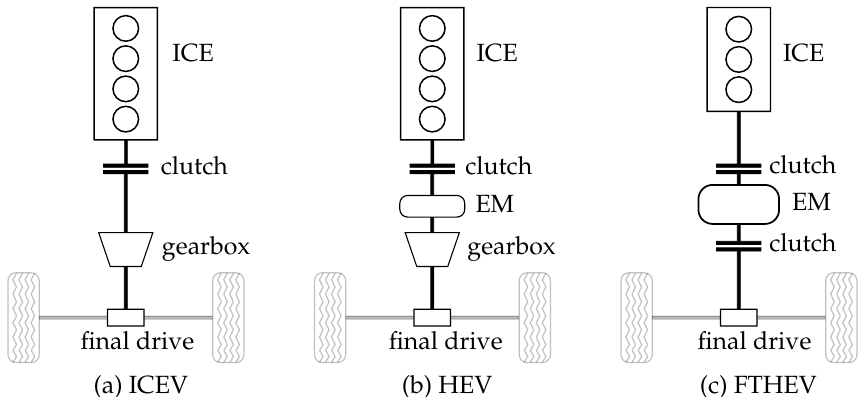
Figure 1. Schematic representation of the parallel hybrid vehicle designs investigated, where ( a ) is an ICEV and serves as a reference design with regard to the fuel consumption, ( b ) is an HEV (also possible as PHEV) realized with a P2 architecture, and ( c ) is an HEV concept with a high DOH (thus rather but not necessarily a PHEV) without a gearbox but with a fixed transmission ratio. Table 1. Mid-class vehicle